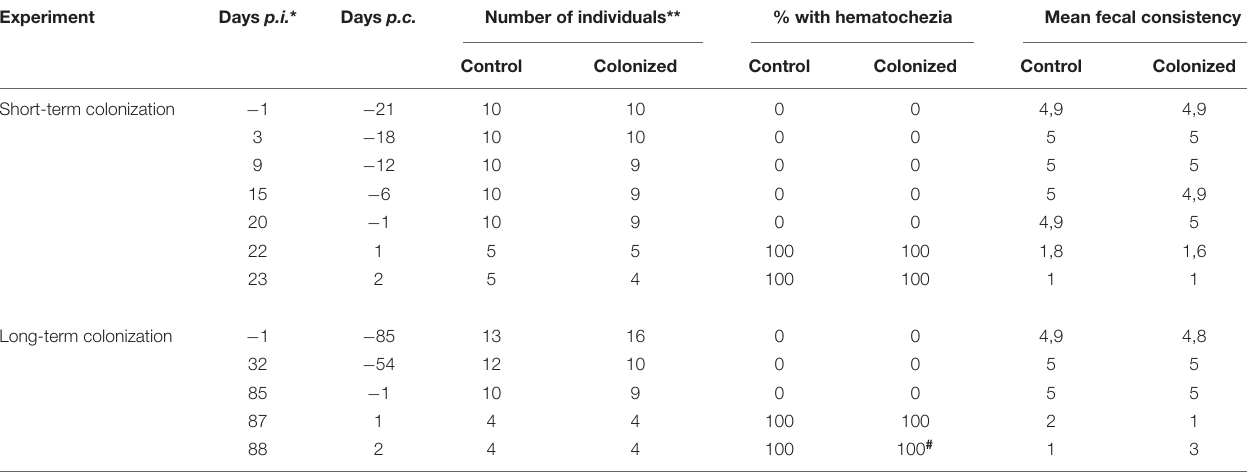
TABLE 1 | Clinical response to colitis with and without Blastocystis ST3 after short-term and long-term colonization. Experiment Days p.i. * Days p.c. Number of individuals** % with hematochezia Mean fecal consistency Control Colonized Control Colonized Control Colonized Short-term colonization − 1 − 21